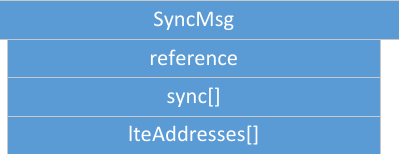
Figure 3. SyncMessage : all vehicles in a platoon need to synchronize to the same request (reference) prior to perform Feudalistic Platooning , i.e., agreeing on Feudalistic Platooning (sync[]) and sharing their LTE address (lteAddress[]).